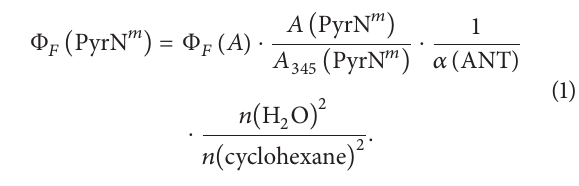
𝐴( PyrN 𝑚 ) stands for the fluorescence emission spectra of the sample from 360 to 600 nm; 𝐴 345 ( PyrN 𝑚 ) is the absorbance is a slope of the fluorescence emission area versus 𝐴 345 cali- bration curve of anthracene; 𝑛( H 2 O ) is a refractive index of water, 𝑛( H 2 O ) = 1.3328 ; 𝑛 (cyclohexane) is a refractive